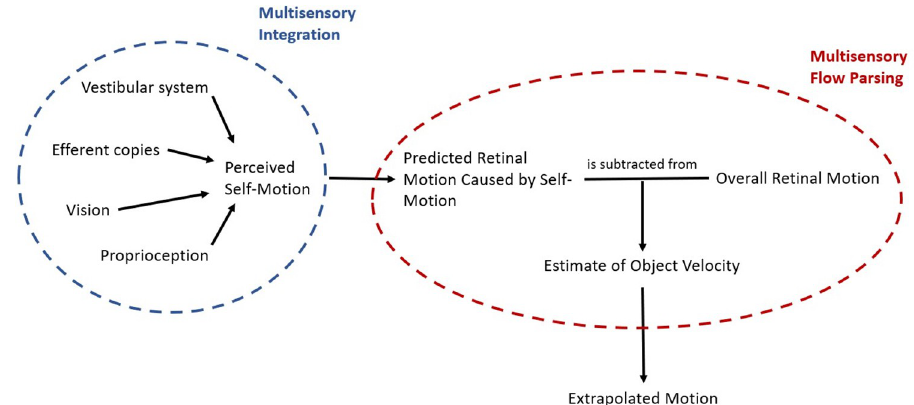
Fig 1. Schematic of the processes at play when predicting motion during self-motion. First, an estimate of the self- motion velocity is obtained by integrating the available cues from different sensory sources. This velocity estimate is used to predict the retinal motion that would be caused by self-motion. Finally, an estimate of the physical object velocity is obtained by subtracting the predicted retinal motion due to self-motion from the global retinal motion and the further trajectory of the object is extrapolated based on this